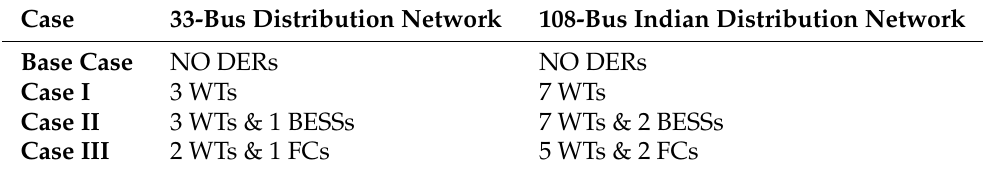
Table 4. Number of DERs to be optimal